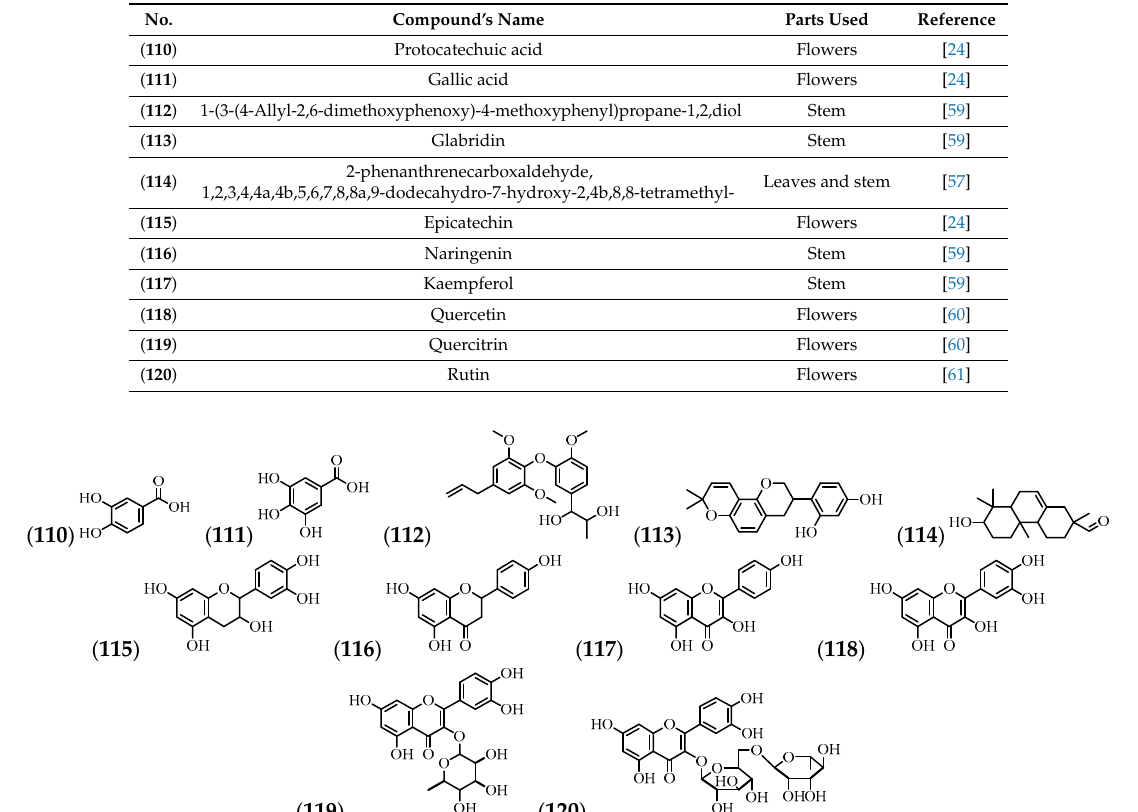
Table 5. The phenolic compounds and flavonoids from A. cathartica.